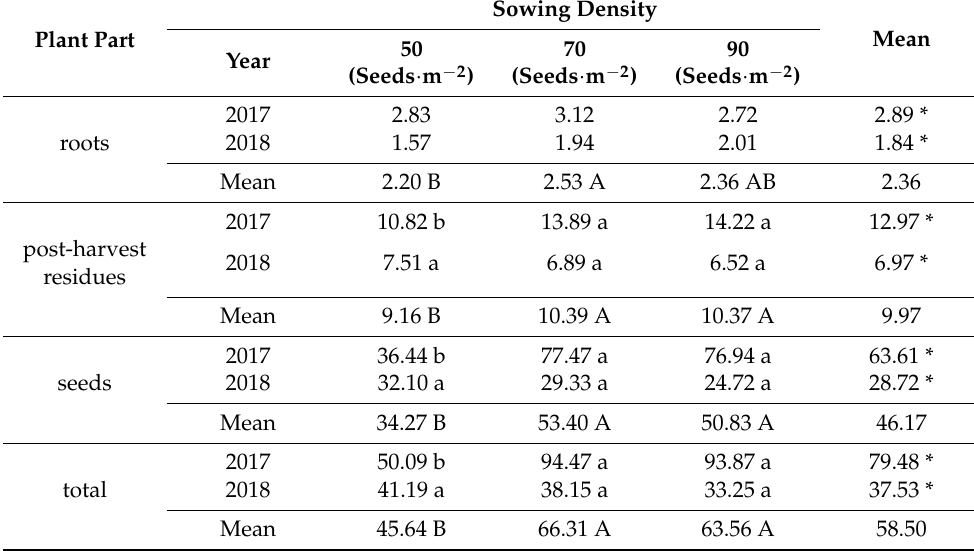
For explanations see Table 2. Table 6. Nitrogen amount taken up by soybean from fertilizer, kg N · ha − 1 . Plant Part